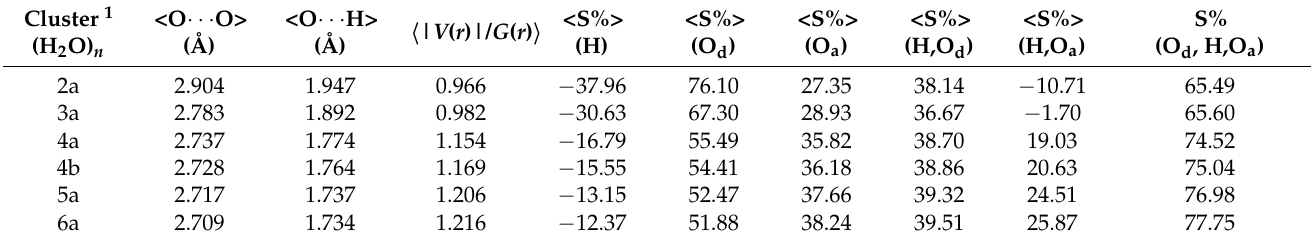
Table 2. Average source contributions at the BCP of the HB, O···H.